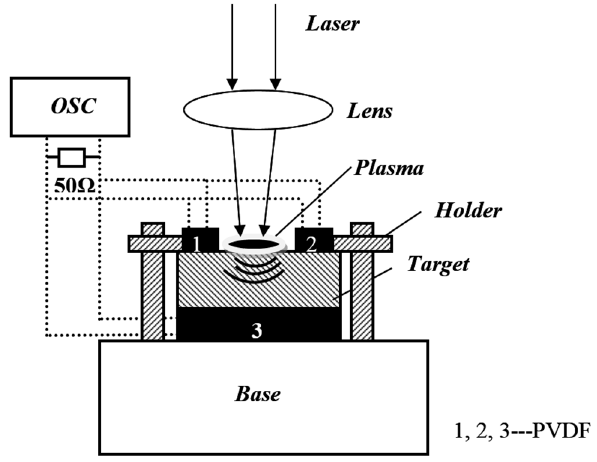
Figure 1. Shock wave measurement experiment device schematic.